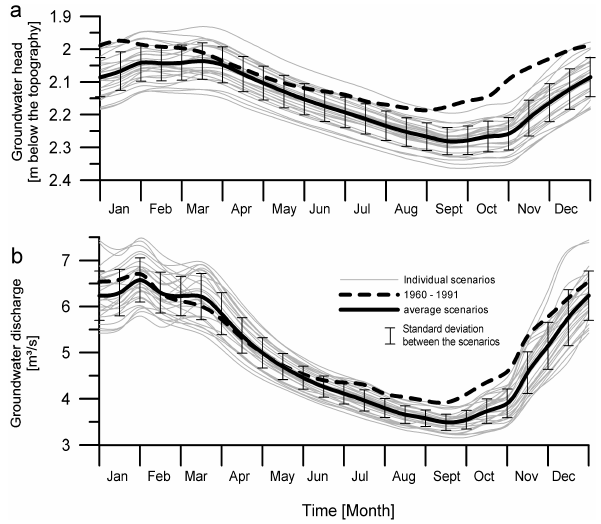
Fig. 8. Average intra-annual variability of (a) groundwater head and (b) groundwater discharge for the reference climate (1960–1991), 28 climate scenarios (2070–2101) and the average of the climate scenarios. One year is divided into 24 half monthly time steps, for every time step the average of 32yr simulation is presented. Error bars represent one standard deviation between the climate